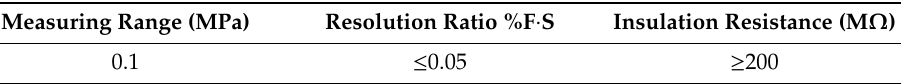
Table 2. Physical specifications of earth pressure cell.